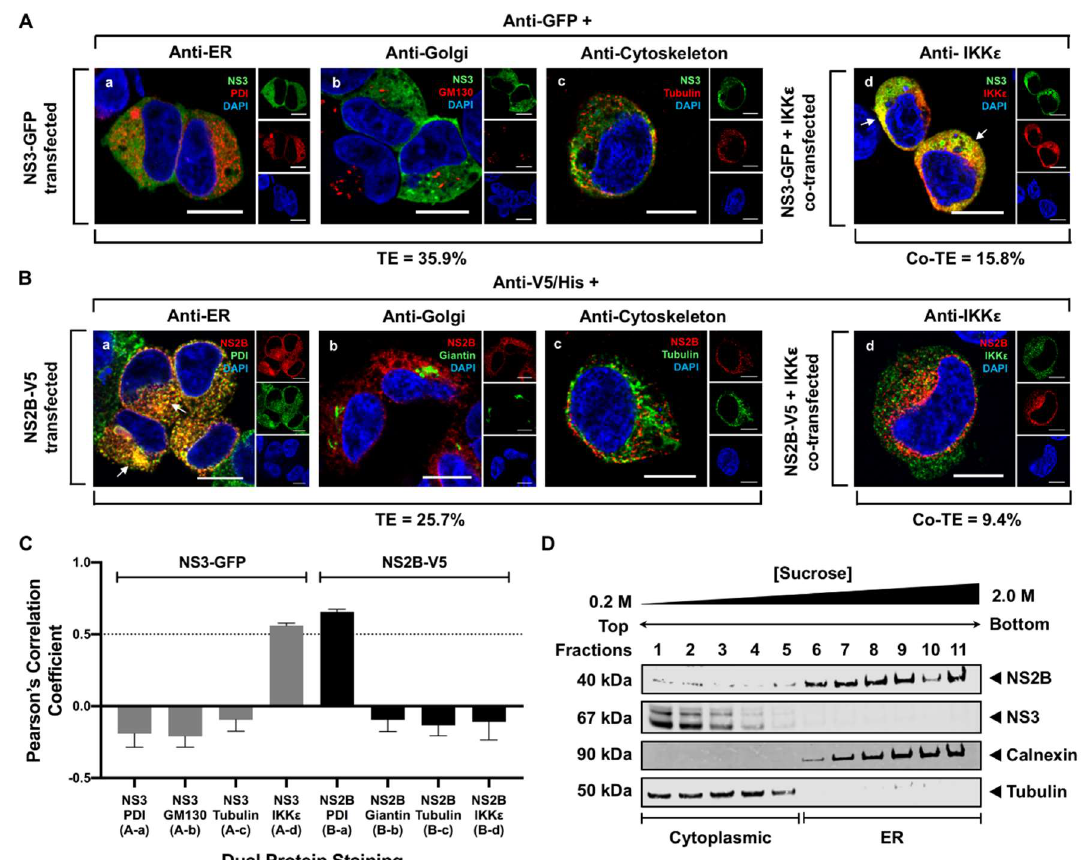
Figure 2. WNV NS3 is distributed throughout the cytoplasm, while NS2B remains in the ER in transfected cells. ( A ) NS3-GFP transfected ( a – c ) or NS3-GFP and IKK ε -FLAG co-transfected ( d ), HEK293T cells were fixed at 24 h post-transfection and immunostained with antibodies against protein disulfide isomerase (PDI), an ER marker, (red; a ), anti-GM130, a Golgi apparatus marker, (red; b ), anti-tubulin, a cytoskeletal marker, (red; c ), or anti-IKK ε , a soluble cytoplasmic protein marker, (red; d ). ( B ) NS2B-V5/His transfected ( a – c ) or NS2B-V5/His and IKK ε -FLAG co-transfected ( d ) HEK293T cells were fixed 24 h after transfection and immunolabeled with rabbit anti-PDI (green; a ), anti-giantin (green; b ), anti-tubulin (green; c ) or anti-IKK ε (green; d ) antibodies to visualize the ER, Golgi apparatus, cytoskeleton or the cytoplasmic protein kinase IKK ε protein, respectively. Visualized viral and host proteins are listed on the top right corner of each panel. Nuclear DNA was labeled with DAPI. Confocal microscopy images were of optical slice thickness ~1 μm. Scale bar, 10 μm. The main image depicts the merged image from three channels separately shown on the side. White arrows indicate colocalization between the green and red channels. The transfection efficiency (TE) for cells transfected with one construct or the co-transfection efficiency (Co-TE) for cells co-expressing the viral protein and IKK are listed at the bottom of each panel. Images are representative of two independent transfection experiments. ( C ) Colocalization analysis between viral proteins and host markers was conducted using Coloc 2 (FIJI). Pearson’s correlation coefficient (PCC) was calculated for each indicated pair of proteins in NS3-GFP (gray bars) or NS2B-V5 (black bars) transfected cells. PCC values larger than 0.5 (dotted line) indicate a high probability that pixels from the red and green channels overlap. Parenthesized letters link each PCC value to its corresponding confocal image in Figure 2A or 2B. Error bars indicate mean ± SEM; n = 5–10 cells per group. ( D ) NS2B-GFP or NS3-V5 singly transfected HEK293T cells were lysed 48 h post-transfection and fractionated by sucrose gradient centrifugation. Cell fractions were analyzed by Western blot using mouse anti-GFP or rabbit anti-V5 antibodies to detect the NS2B and NS3 proteins, respectively. The cytoplasmic and ER fractions were visualized using anti-tubulin and anti-calnexin antibodies, respectively.